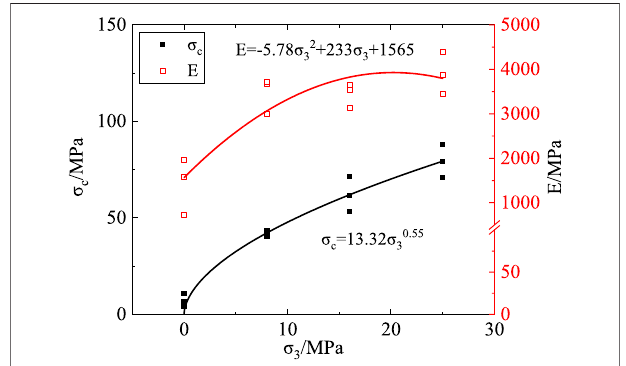
FIGURE 4 | Compressive strength and elastic modulus of coal under different con fi ning